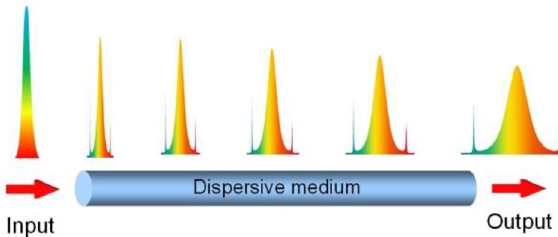
Figure 9: Schematic diagram of TS-DFT technique. The ultrashort pulses are stretched and mapped into the temporal domain through enough